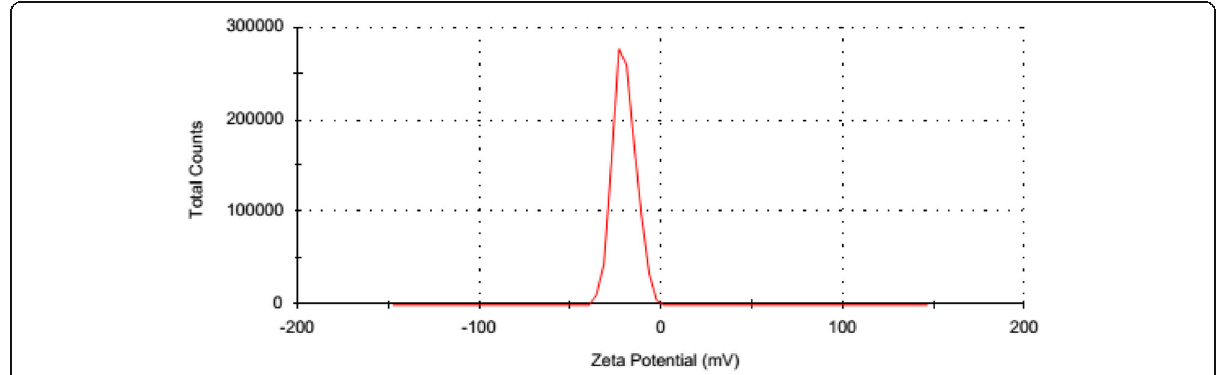
Fig. 5 Zeta potential plot of synthesized AuNPs